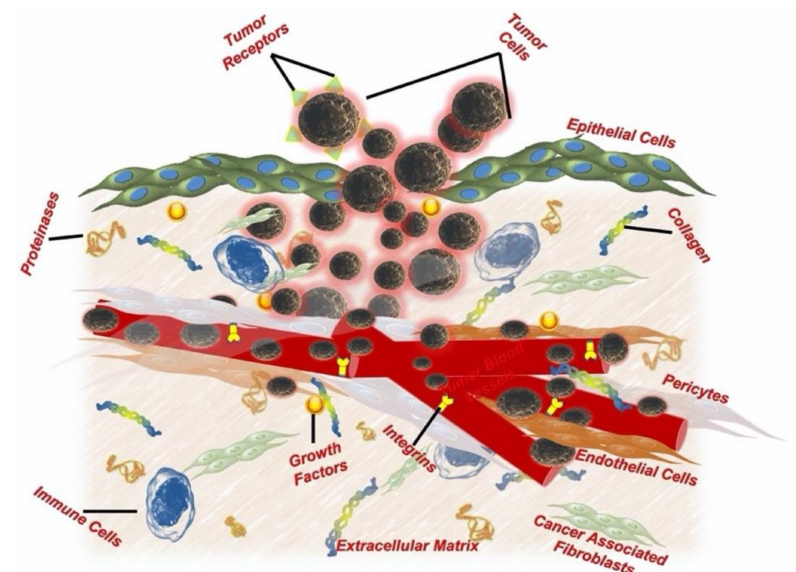
Figure 1. Solid tumor’s microenvironmental